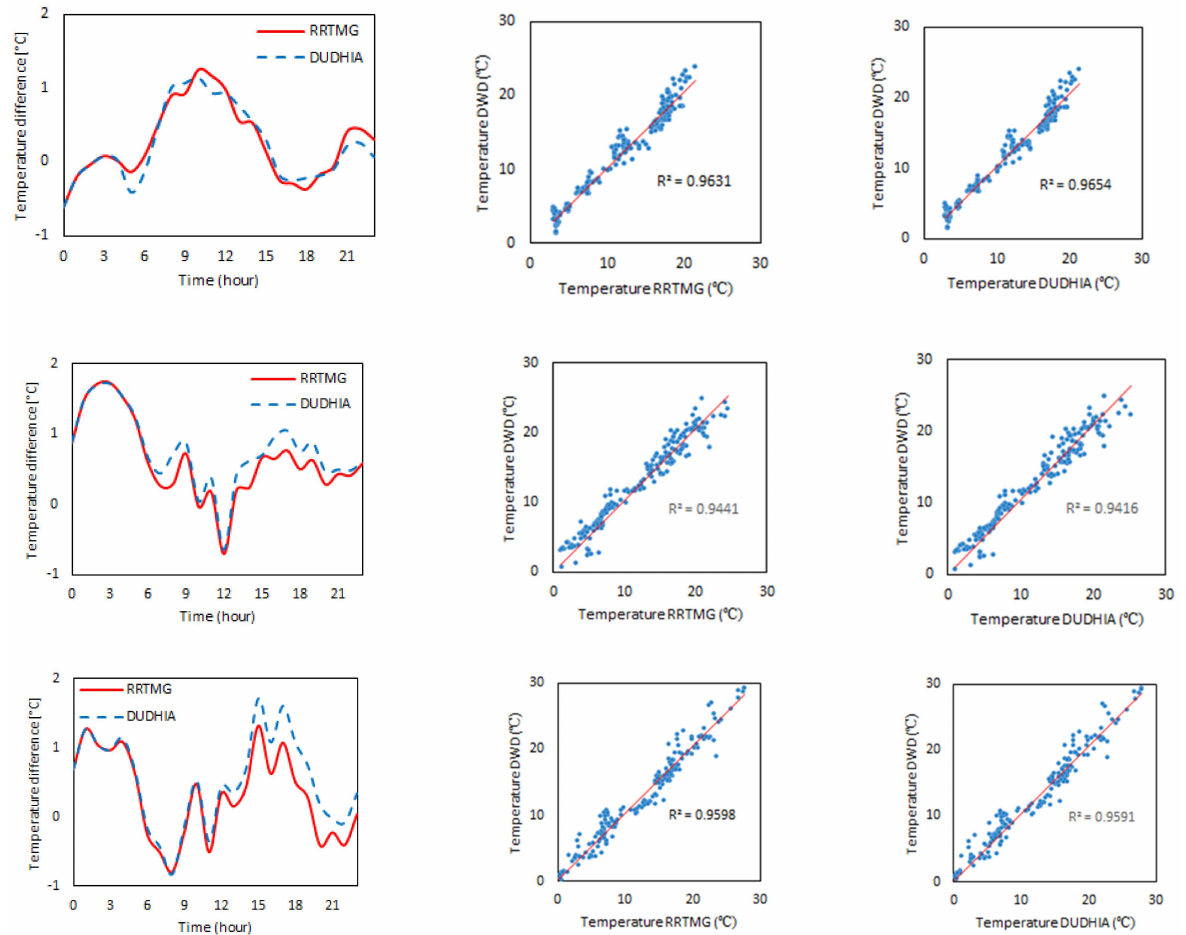
Figure 6. Graphs showing the average air temperature differences (left) and their scatter [ ◦ C], from top: Arkona, Rostock-Warnemünde, and